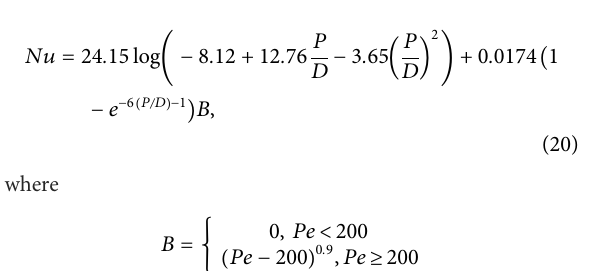
FIGURE 7 Temperature difference in different cross-sections.